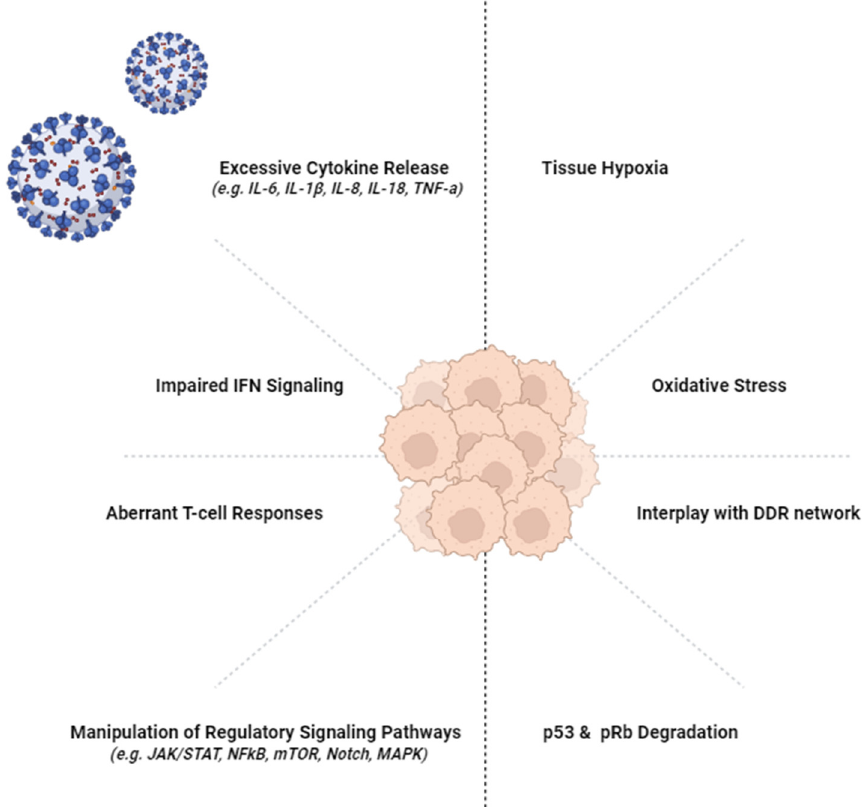
Figure 1. The shared molecular mechanisms between SARS-CoV-2 and oncogenesis. The figure was generated using images assembled from BioRender (available online: https://biorender.com, accessed on 30 August 2022).